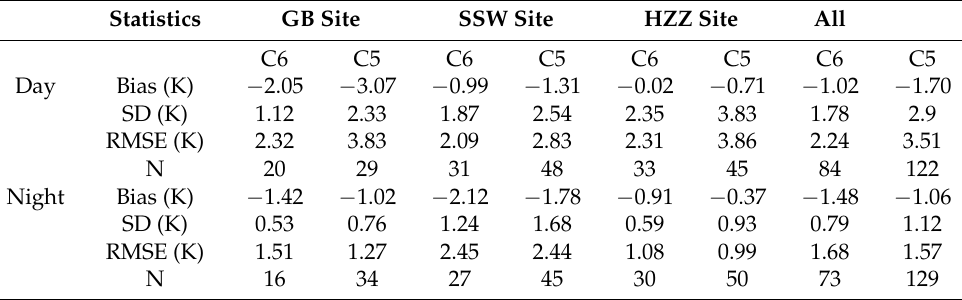
Table 4. Summary of the evaluation results of MODIS C5 and C6 1-km LST products obtained from the Aqua satellite at three